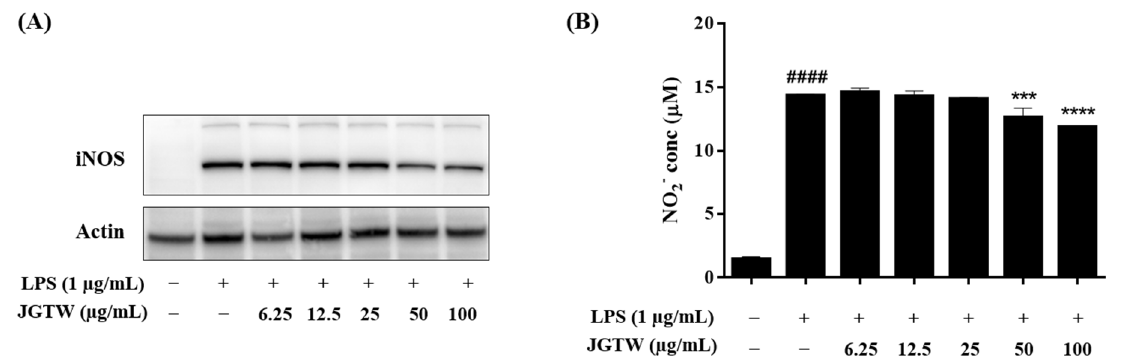
Figure 6. Effect of JGTW on the expression of iNOS and NO production in LPS-stimulated RAW264.7 cells. Cells were pretreated with JGTW (6.25 to 100 μ g/mL) and stimulated with LPS (1 μ g/mL) for 24 h. iNOS expression determined by Western blot analysis ( A ). Concentration of NO in the culture supernatant ( B ). The values are expressed as mean ± SD. #### p < 0.0001 versus vehicle-treated cells; *** p < 0.001 and **** p < 0.0001 versus LPS -stimulated cells.